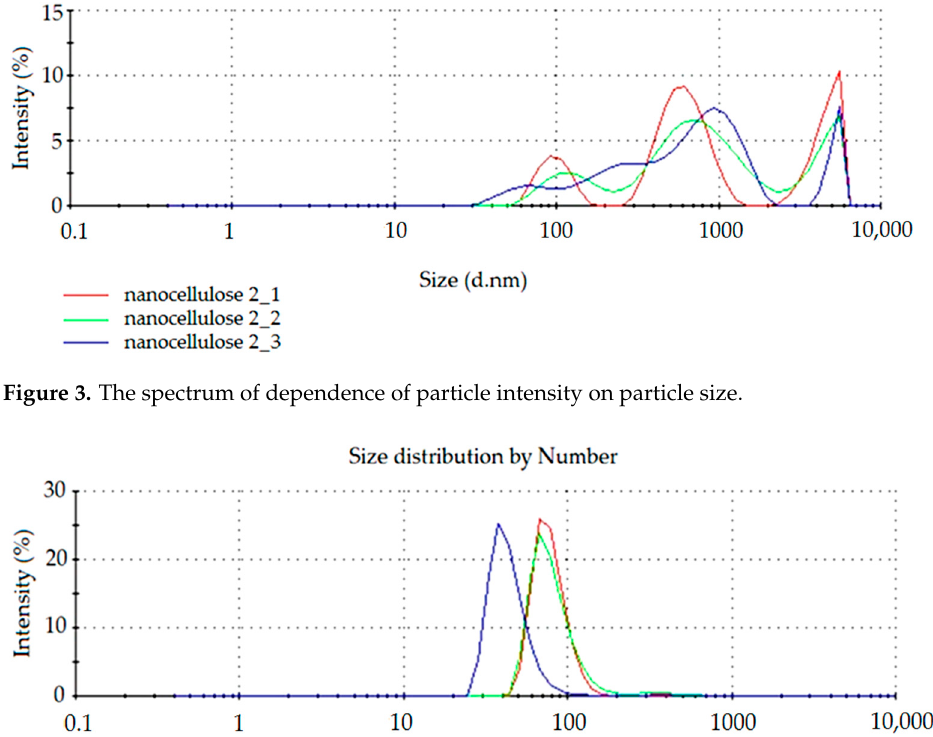
Figure 4. The spectrum of dependence of the number of particles on their size.